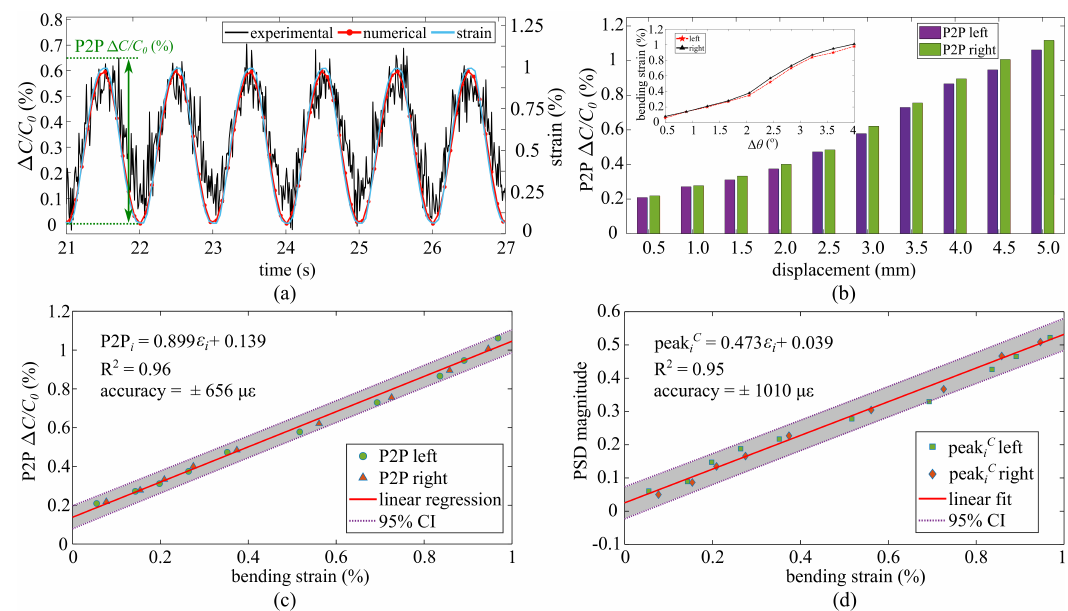
Figure 8. ( a ) Comparison of experimental and numerical signals for ∆ C / C 0 under a 4.0 mm maximum displacement; ( b ) P2P ∆ C / C 0 amplitude as a function of displacement with the inset showing bending strain as the function of angular rotations ( ∆ θ ); ( c ) linear regression of the P2P amplitudes with respect to bending strain; ( d ) linear regression of the PSD amplitudes with respect to bending strain.